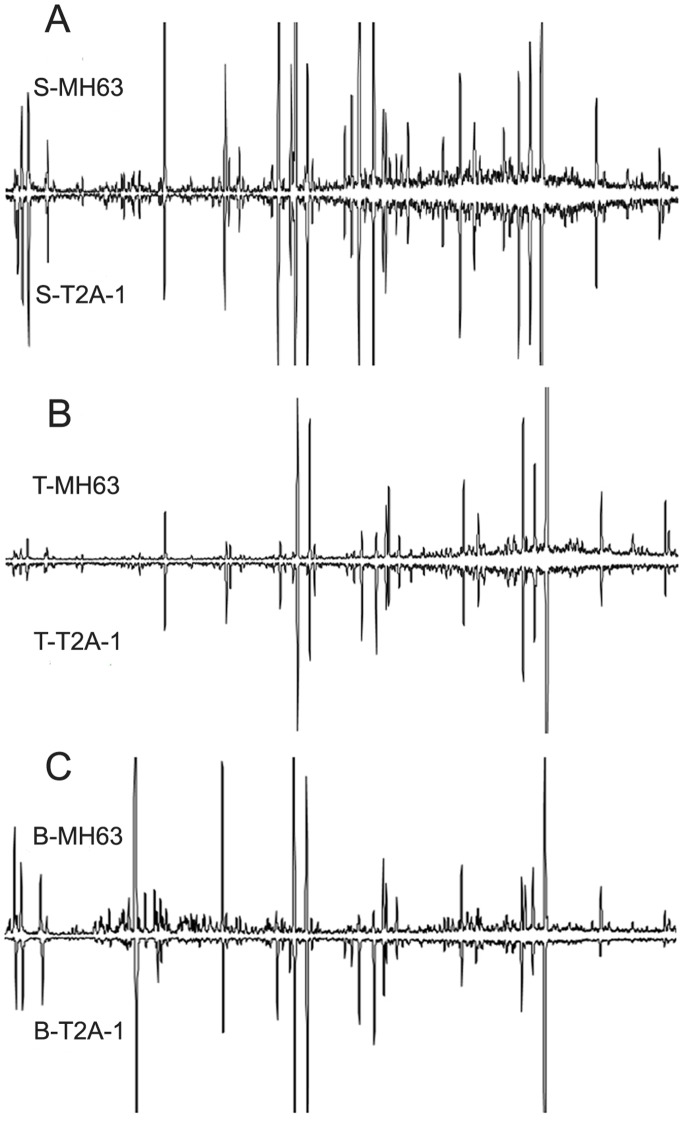
Gas chromatography-mass spectrometry (GC-MS) profiles of representative solvent extracts of Bt and non-Bt rice cultivars: (A) seedling stage (S); (B) tillering stage (T); (C) booting stage (B).